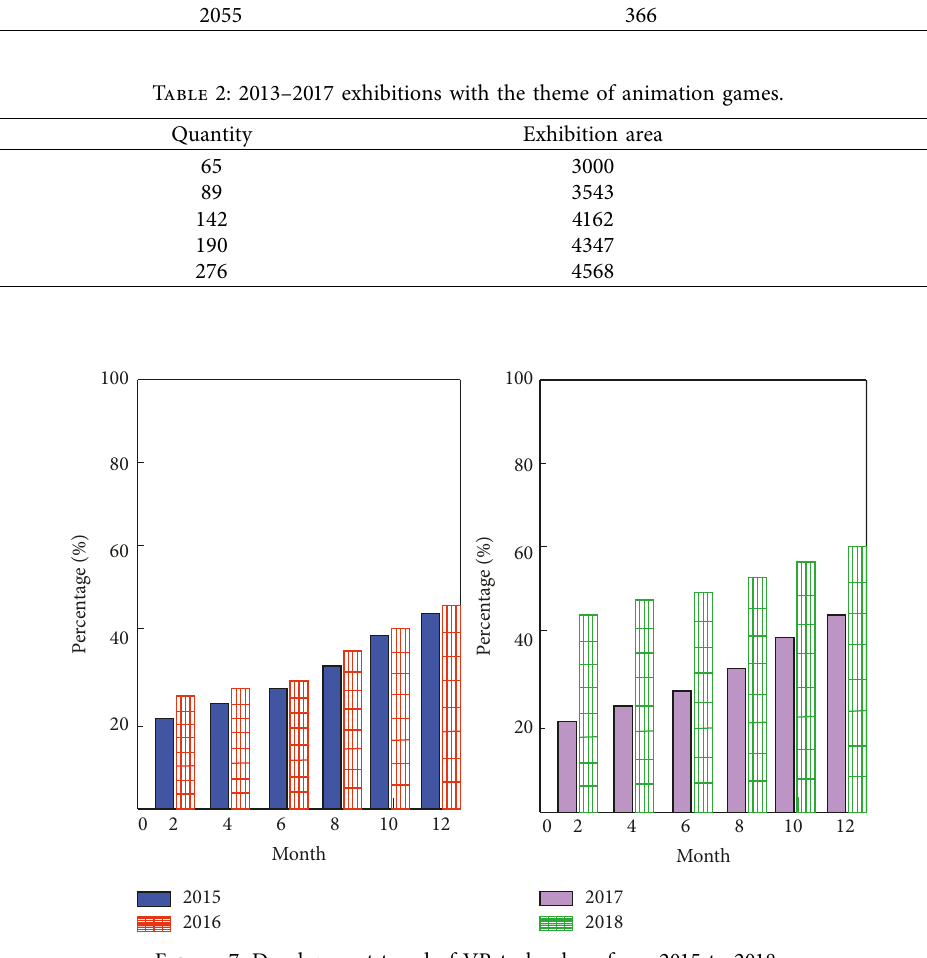
Figure 7: Development trend of VR technology from 2015 to